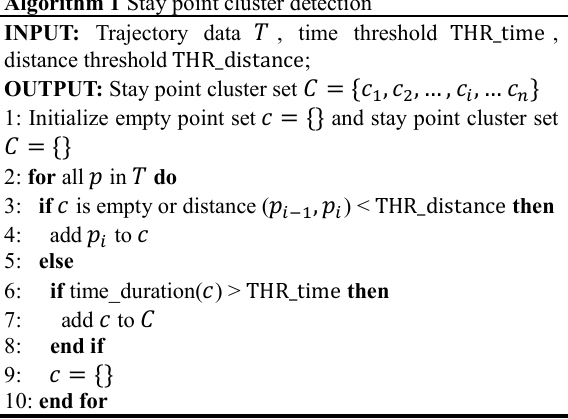
Algorithm 1 Stay point cluster detection